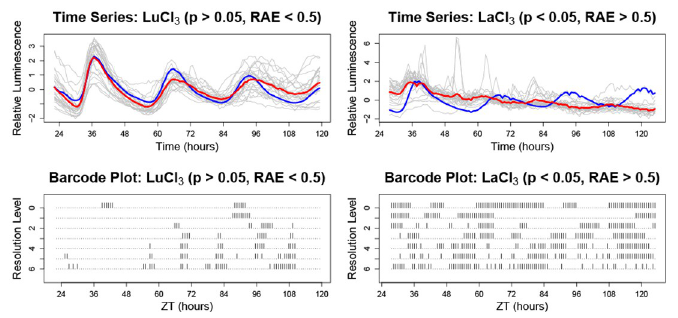
Fig 4. Detecting spectral differences using wavelet spectral testing. Examples (Fig 1 panels (c) and (d)) showing clear circadian disruption not captured by FFT–NLLS ( p > 0.05 or RAE > 0.05), but captured by LSW–FT. Top panels: individuals in the treatment group (grey) are shown along with the treatment group average (red) and the control group average (blue). Each time series has been standardised to have mean zero. Lower panels: Barcode plots indicating the time–scale locations of significant spectral differences (LSW–FT with FDR, p < 0.05) between the control and treatment group.